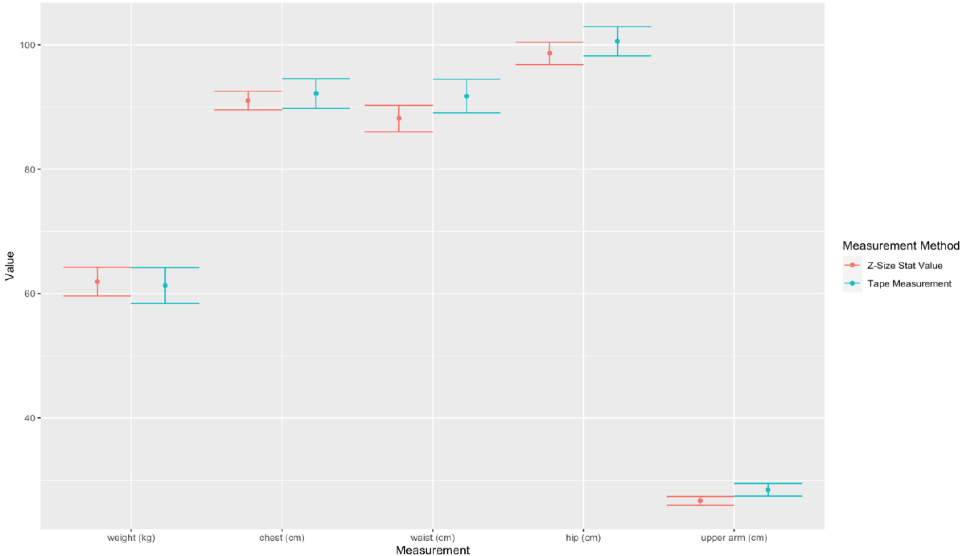
Figure 10. 95% Confidence Interval (CI) plot for the mean measurements (74 postpartum volun-